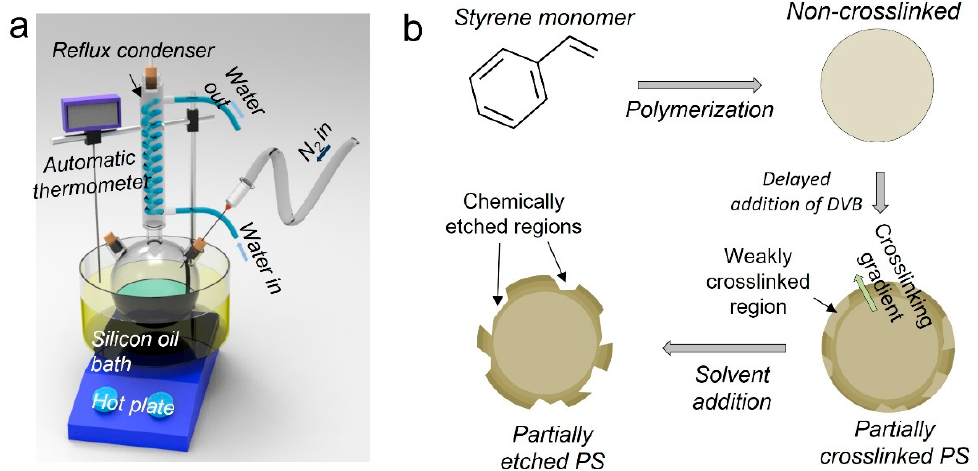
Figure 1. Schematic illustration of fabricating the partially etched PS NPs. ( a ) Experimental setup. ( b ) Proposed mechanism.